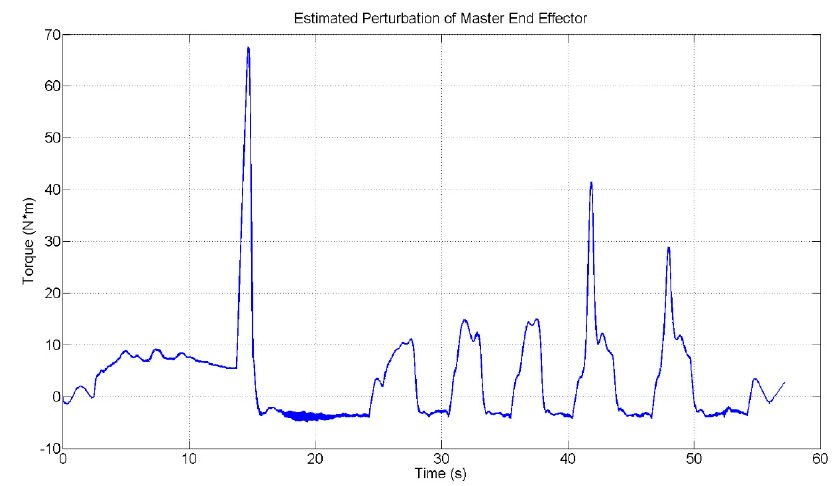
Figure 12. Error between master–slave trajectories for end effector.